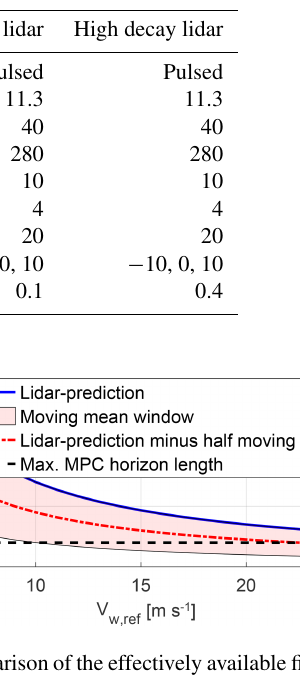
Figure 6. Comparison of the effectively available filtered prediction information (dash-dotted red) to the MPC horizon length (dashed